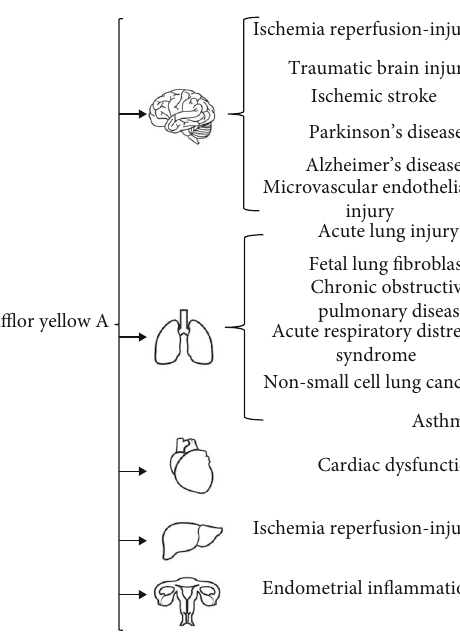
Figure 2: The molecular mechanisms of hydroxysa ffl or yellow A in the treatment of in fl ammation-related diseases. Abbreviations: GSK3 β : glycogen synthase kinase-3 β ; NF- κ B: nuclear factor- κ B; TLR9: toll-like receptor 9; TLR4: toll-like receptor 4; TLR2: toll-like receptor 2; MAPK: mitogen-activated protein kinase; JAK2: Janus kinase 2; STAT3: signal transducers and activators of transcription 3; PI3K: phosphatidylinositol 3-kinase; Akt: protein kinase B; mTOR: mammalian target of rapamycin; cAMP: cyclic adenosine monophosphate; PKA: protein kinase A; ERK: extracellular signal-regulated kinase; TNF- α : tumor necrosis factor- α